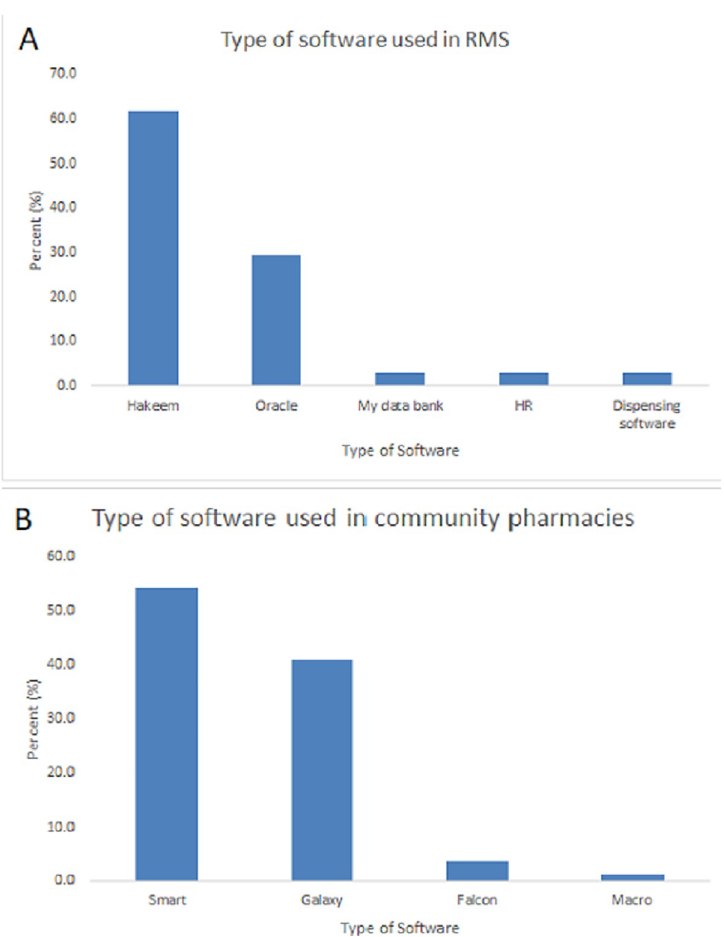
Fig 4. Type of software used in pharmaceutical services. (A) software used in Royal Medical Services (RMS). (B) software used in Community